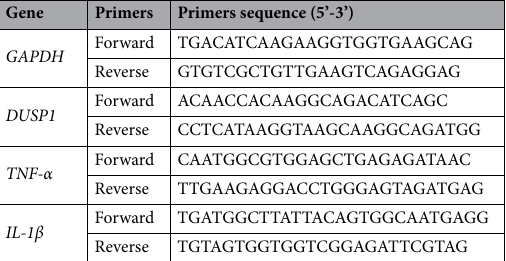
Table 2. Gene specific primers for